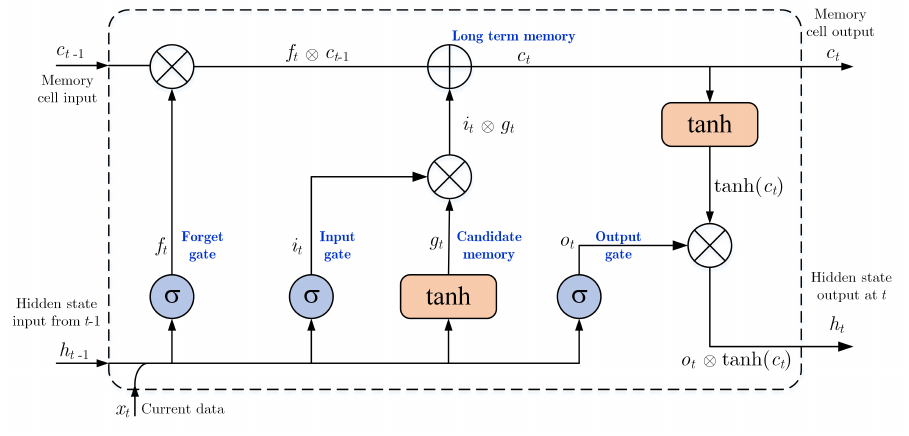
Figure 3. The structure of an LSTM